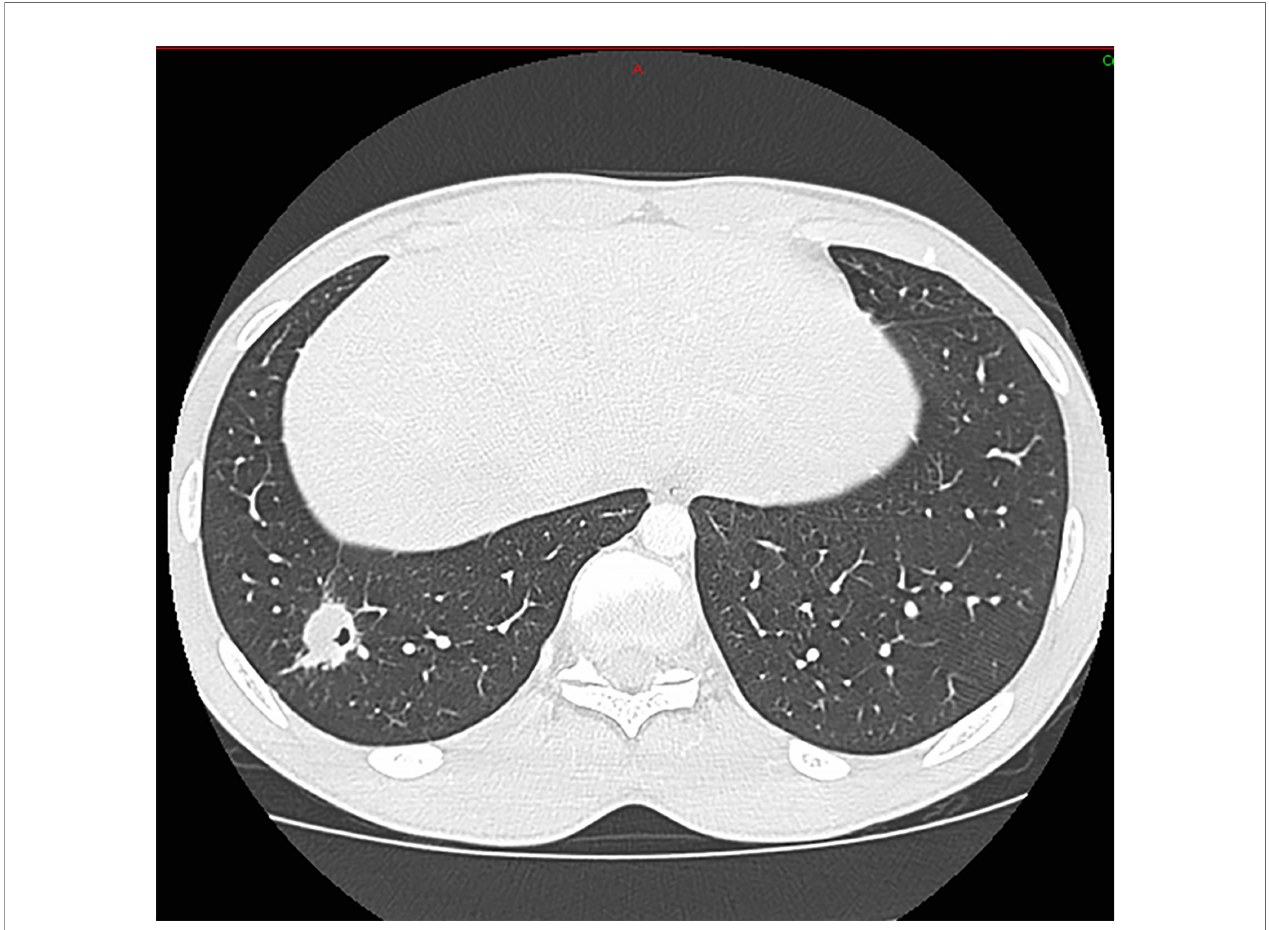
FIGURE 2 | Pulmonary Computed Tomography – scan with pulmonary nodule of the right basad pyramid